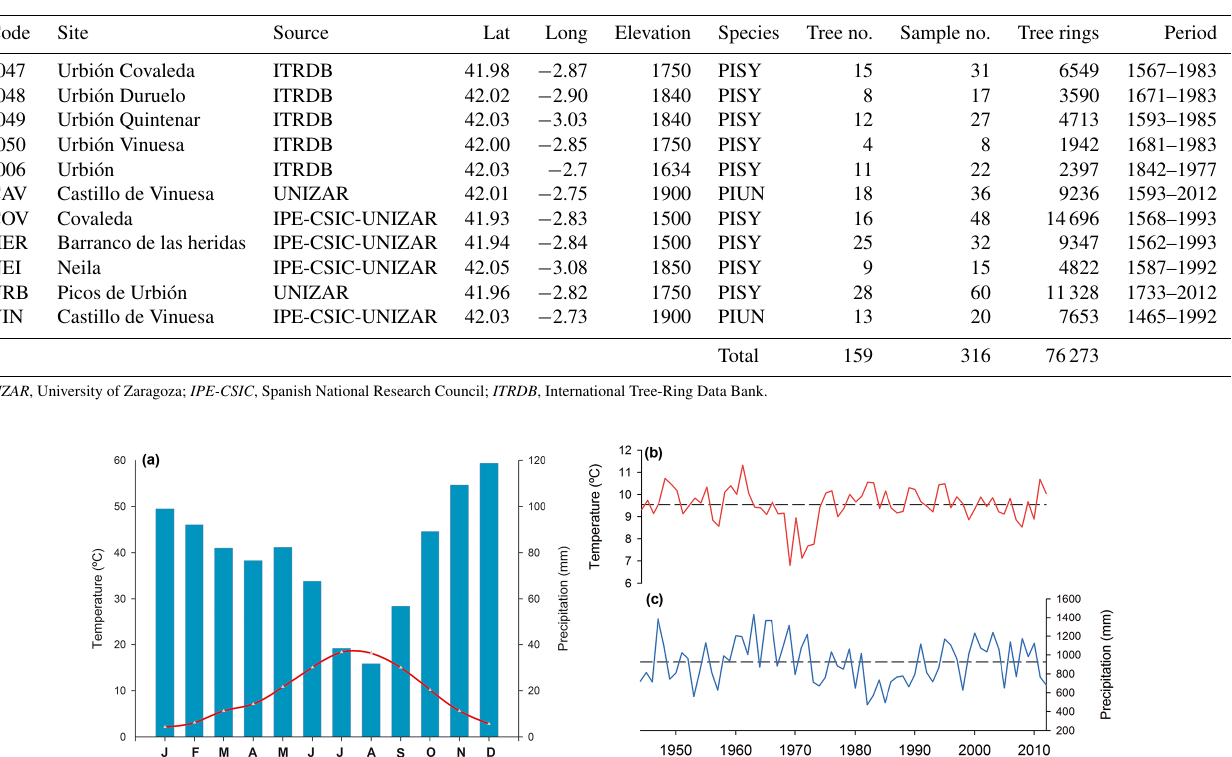
Table 1. Tree-ring sites’ characteristics.